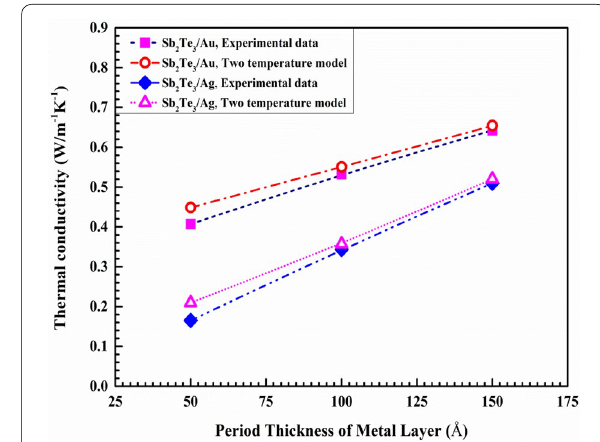
Fig. 6 Simulation versus experimental